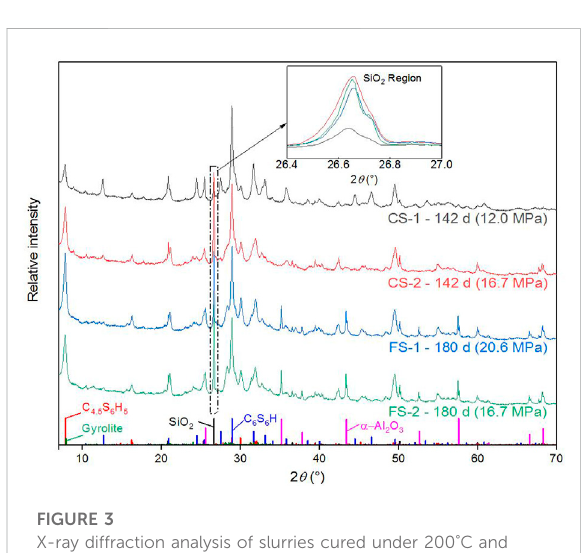
FIGURE 3 X-ray diffraction analysis of slurries cured under 200 ° C and 50 MPa for the long-term (the data in the brackets is the compressive strength of the